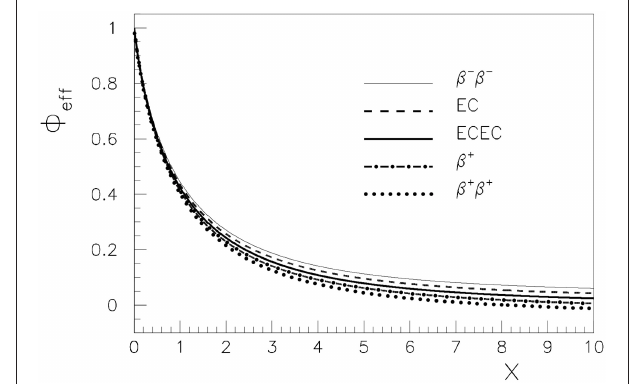
FIGURE 3 | The effective screening function φ eff as function of the dimensionless parameter x calculated for the 136 Xe parent nucleus. The thin full line corresponds to the β − β − decay, the thick dashed line is for the EC process, the thick full line is for the ECEC process, the dot-dashed thick line is for the β + process and the dotted thick line is for the β + β +